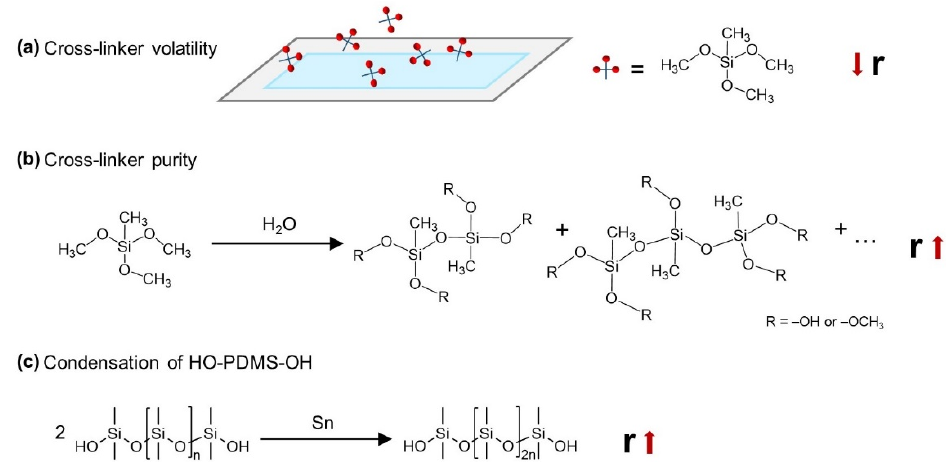
Figure 1. Factors influencing the true stoichiometric ratio, r = f[cross-linker]/2[HO-PDMS-OH], in a condensation curing silicone elastomer formulation [10]. The example shown is a system consisting of HO-PDMS-OH, methyltrimethoxysilane (f = 3), and a tin catalyst: ( a ) Cross-linker volatility, ( b ) hydrolysis-condensation reaction of the cross-linker molecules during storage leading to cross-linker impurity, and ( c ) condensation reaction of HO-PDMS-OH in the presence of a tin catalyst.